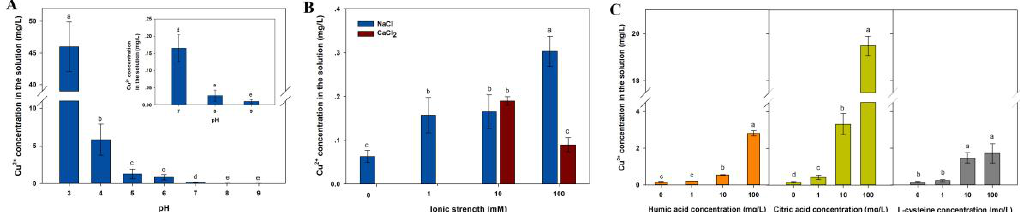
Figure 5. Dissolution of CuO NPs (100 mg/L) in the solution with varying pH ( A ); ionic strength, and ionic valence ( B ); and different amount of humic acid, citric acid, and L -cysteine ( C ). The insert in